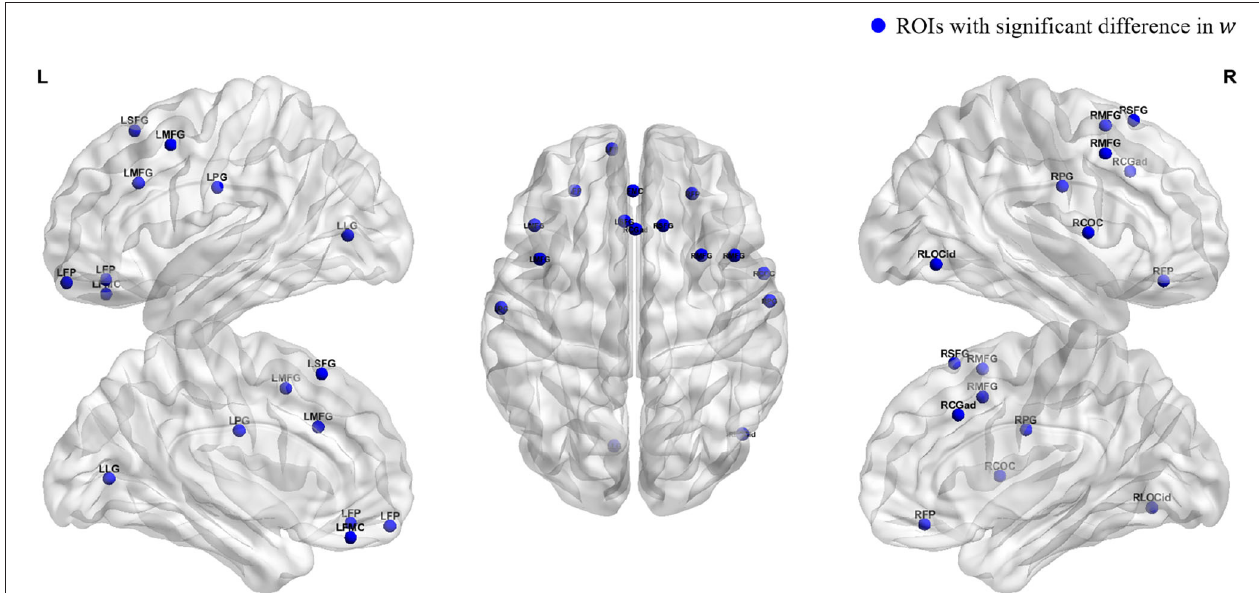
FIGURE 3 | Spatial locations of ROIs. Blue dots indicate the locations of the ROIs which the parameter w is